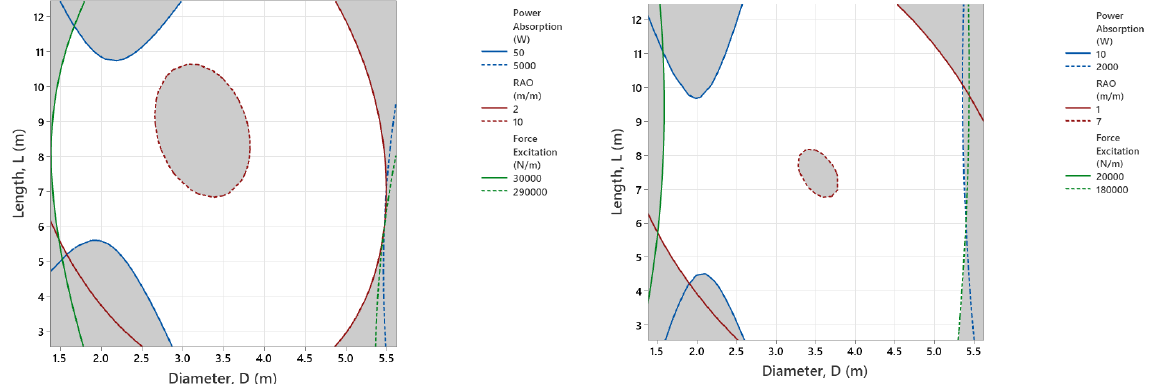
Figure 13. Contour Plot of the Condition Parameters (Length and Diameter) for PA Front Position ( Left ) and Back Position ( Right ).